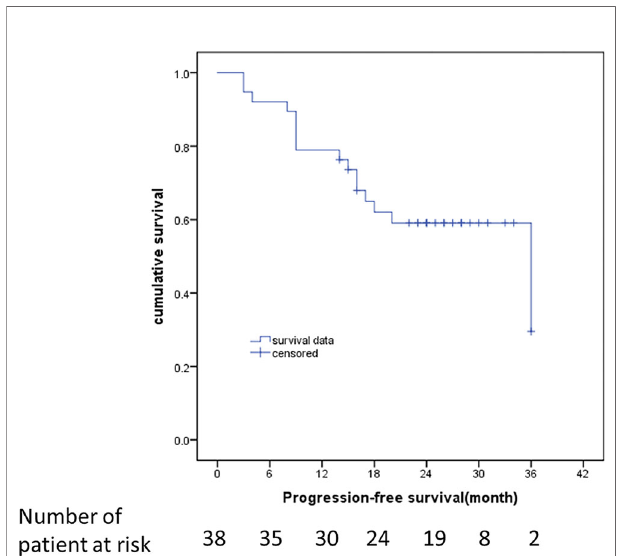
FIGURE 3 | Kaplan – Meier estimates of the duration of PFS at the time of last assessment. RECIST 1.1 was used to identify disease progression. Data from patients who did not have progression were censored and marked by a